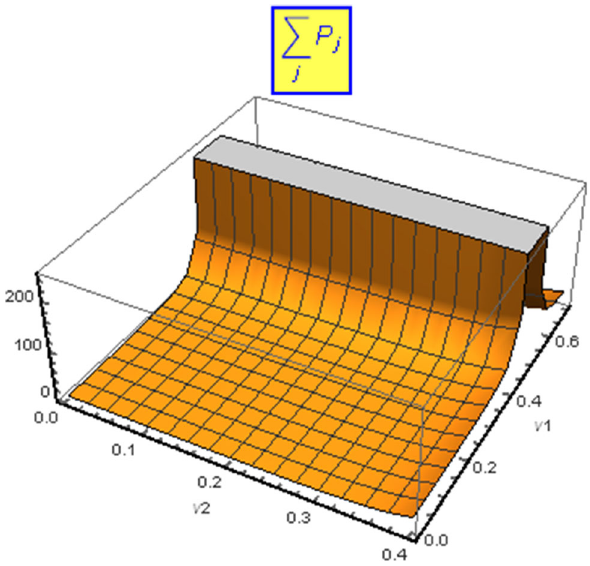
Fig. 7 This figure shows the behavior of function of power spectrum ) introduced in Eq. (21). In this frame we consider same quantities P (ν j for parameters ν